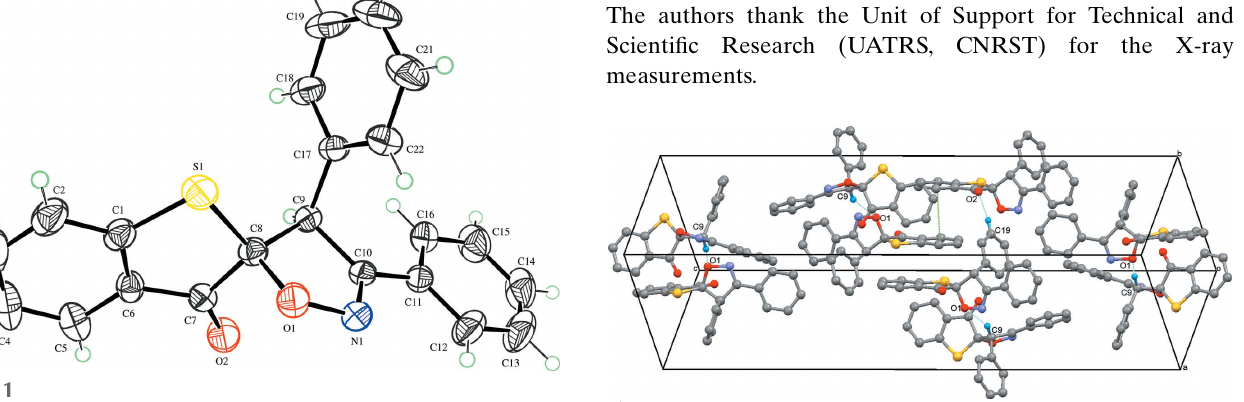
Figure 2 Crystal packing for the title compound showing molecules linked by hydrogen bonds (dashed blue lines) and a (cid:2) – (cid:2) interaction (green line).